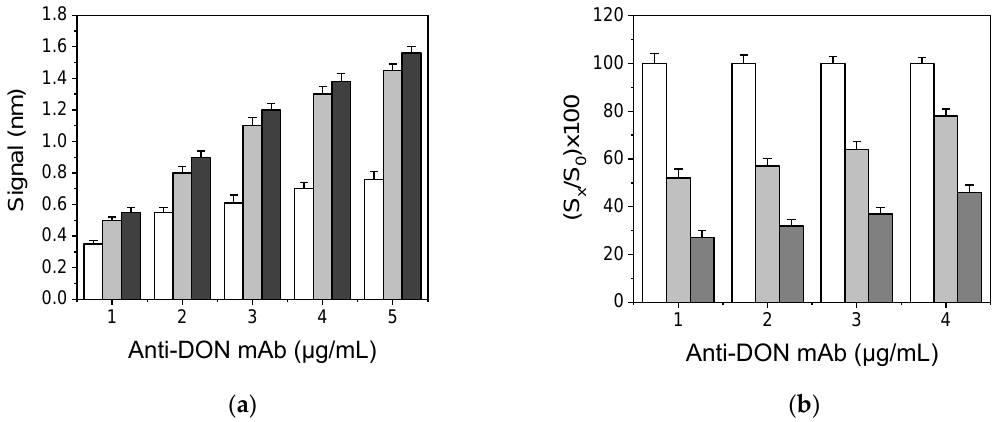
Figure 3. ( a ) Effect of mouse monoclonal antibody against DON (anti-DON mAb) concentration on the zero calibrator signal received from chips coated with 100 (white columns), 200 (light grey columns), or 400 μg/mL DON conjugate with ovalbumin (DON-OVA) (dark grey columns). ( b ) Effect of anti-DON mAb concentration on the percent signal corresponding to calibrators containing 10 ng/mL (light grey columns) and 100 ng/mL DON (dark grey columns) with respect to zero calibrator signal (white columns) obtained from a chip coated with 200 μg/mL of DON-OVA conjugate. In all cases, the duration of both primary and secondary immunoreaction was 10 min. Each point is the mean value of 3 measurements ± SD.